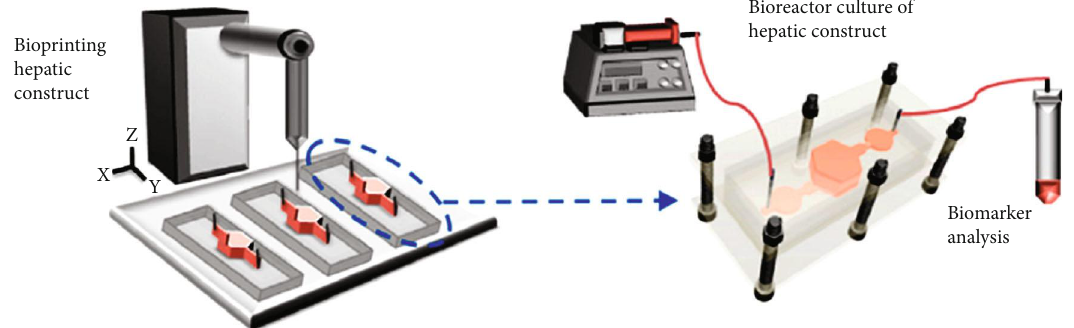
Figure 3: Schematic of the hepatic bioreactor culture platform integrated with a bioprinter and biomarker analysis module [23], ©2018, IOP